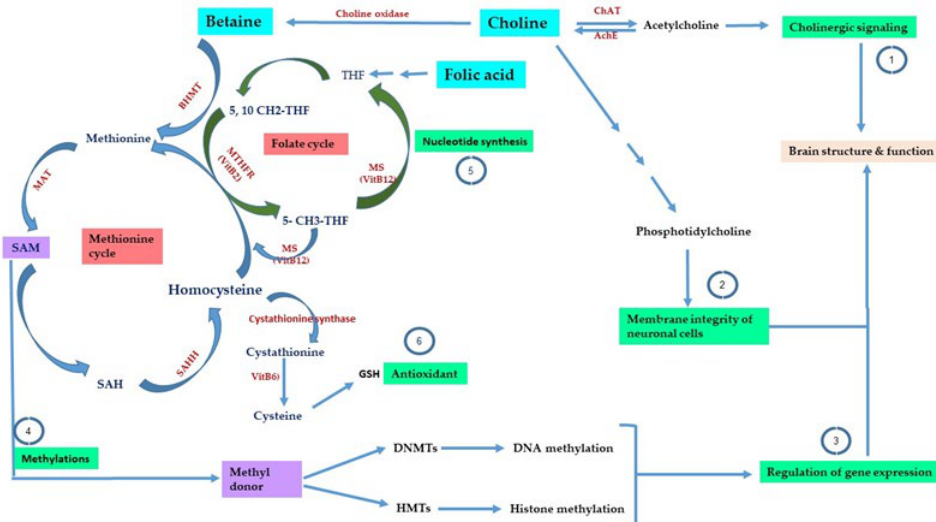
Figure 2. One-carbon metabolism. This figure shows the main components of the one-carbon metabolism, the folate cycle, the methionine cycle, and the contribution of micronutrients such as choline, betaine, folate, methionine, VitB6, and VitB12 in several biological processes. Enzymes and vitamins are written in red and biological processes are highlighted in green. Micronutrients are highlighted in blue. THF: tetrahydrofolate, SAM: S-adenosylmethionine, SHA: S-adenosylhomocys-